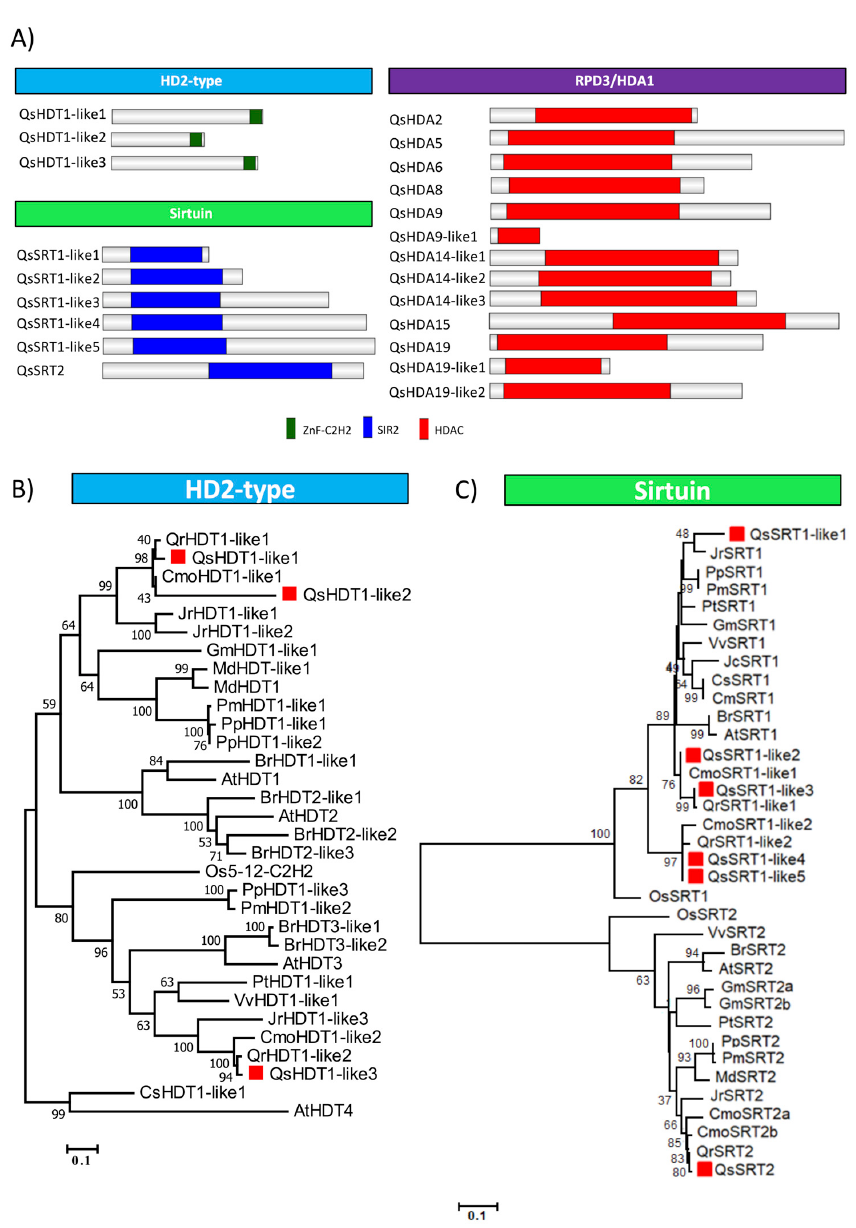
Figure 7. Domain organization ( A ) of HDAC proteins in Quercus suber and the phylogeny of ( B ) HD2 and ( C ) Sirtuin family. ( A ) The proteins and the family they belong to are indicated on left side and above each corresponding schematic diagram, respectively. The different conserved protein domains are depicted in different colors as indicated in the right-side legend. The HDAC domain (PF00850) is the conserved domain of RPD3/HDA1 proteins. C-terminal zinc finger domain C2H2 (PF00096) is typical in the HD2-type proteins. The SIR2 proteins contain an SIR2 domain (PF02146). ( B ) All the protein of HD2-type (HD2 family) and ( C ) SIR2 domain (Sirtuin family) of Quercus suber L. (Qs), Arabidopsis thaliana (L.) Heynh. (At), Brassica rapa L. (Br), Glycine max (L.) Merr. (Gm), Jatropha curcas L. (Jc), Populus trichocarpa Torr. & A.Gray ex Hook. (Pt), Prunus persica (L.) Batsch (Pp), Prunus mume (Siebold) Siebold & Zucc. (Pm), Vitis vinifera L. (Vv), Cucumis melo L. (Cm), Cucumis sativus L. (Cs), Juglans regia L. (Jr), Castanea mollissima Blume (Cmo), Quercus robur L. (Qr) and Oryza sativa L. (Os) were aligned using ClustalW and used to infer the evolutionary history using the Maximum-likelihood method. The evolutionary distances (left side scale bar) were computed using the Jones-Taylor-Thornton (JTT) correction model. The numbers at the nodes represent bootstrap values from 1000 replicates. The Q. suber proteins were indicated with a red square.